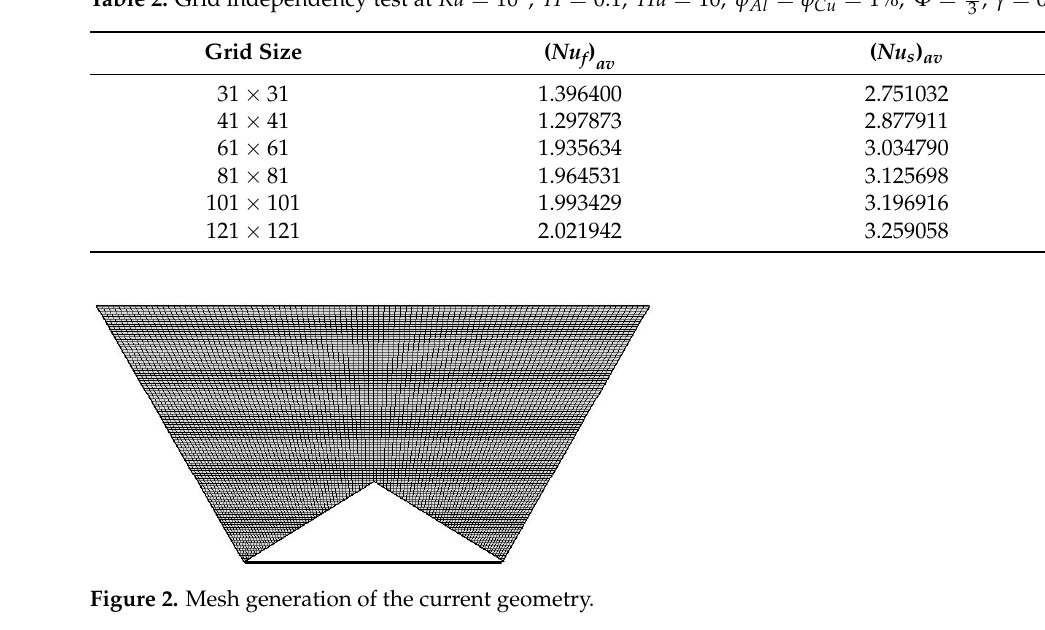
Table 2. Grid independency test at Ra = 10 5 , H = 0.1, Ha = 10, φ Al = φ Cu = 1%, Φ = π